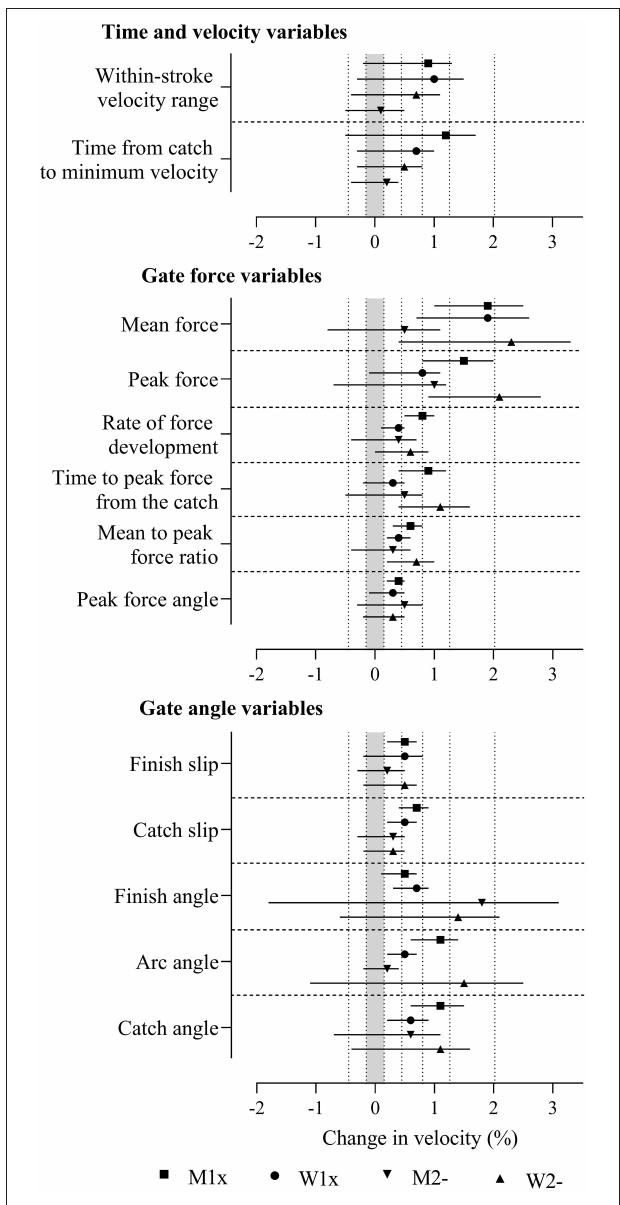
FIGURE 4 | Differences between crews in the effects of the predictor variables shown in Figure 3 in the four boat classes with adjustment for power output and stroke rate. Data are SD (%) and 90% compatibility limits. The shaded grey area covers values within the smallest important difference thresholds (-0.15% to 0.15%). Vertical dotted lines delineate threshold magnitudes of small ( ± 0.15), moderate ( ± 0.45), large ( ± 0.8), very large ( ± 1.26), and extremely large ( ± 2.02). Rejection of the non-inferiority or non-superiority hypothesis occurs when compatibility limits do not enter the grey area. Effects with compatibility limits that end within the grey area have adequate precision but are only possibly or likely substantial. M1x, men’s single sculls; W1x, women’s singles sculls; M2-, men’s coxless pairs; W2-, women’s coxless